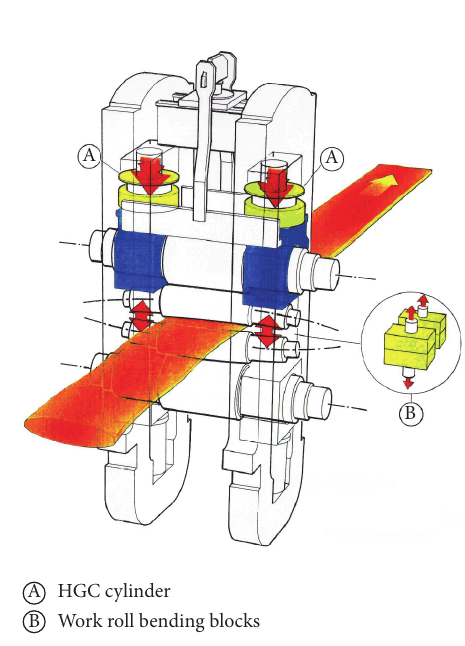
Figure 3: The structure of mill